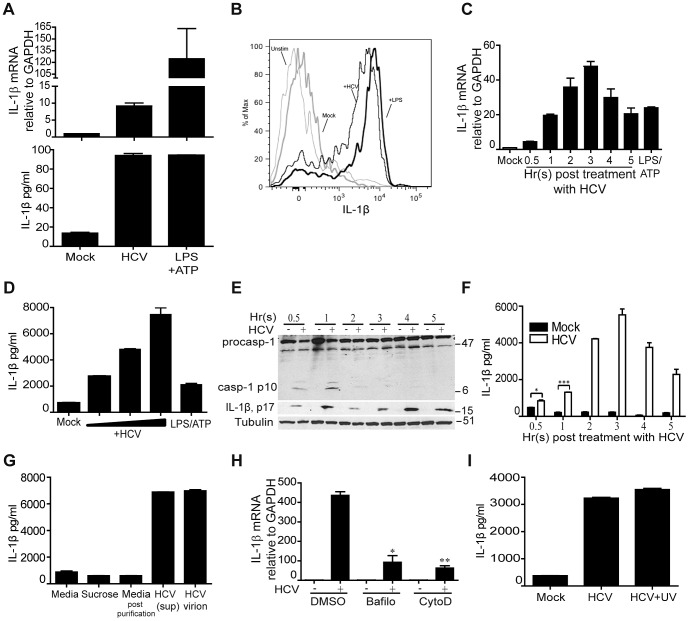
HCV stimulates IL-1β production upon uptake by macrophages.(A) IL-1β mRNA expression (upper panel) and secreted IL-1β protein levels (lower panel) from primary monocyte-derived macrophages of healthy human donor blood. Cells were mock-treated or treated with infectious HCV supernatant (moi = 0.01 based on Huh7 focus forming units (ffu) or treated with 1 µg/ml of LPS and ATP 5 mM (LPS/ATP; positive control). (B) Intracellular cytokine staining of treated CD14+ cells recovered from saline washout of healthy donor liver. Cells were left untreated (unstim) or were cultured with conditioned media (mock, negative control), LPS (positive control) or treated with UV-inactivated HCV (moi = 0.01 based on Huh7 focus forming units (ffu)). Data are shown from one donor and are representative two experiments each of cells collected from two independent donors. In the analysis shown the frequency of IL-1β-expressing cells was: unstim, 2.7%; mock, 6.4%; LPS, 76.5%; UV-HCV. 67.6%. (C)–(I) Analysis of THP1 cells. (C) IL-1β mRNA expression post exposure to HCV. (D) IL-1β protein secretion after treatment with variable doses of HCV (moi = 0.001, 0.01 or 0.1 Huh7 ffu) or LPS/ATP at 1 µg/ml for 24 hr. (E) Immunoblot showing the kinetics of caspase-1 activation after HCV exposure. (F) Levels of secreted IL-1β over a time course after HCV exposure (moi = 0.01 based on Huh7 ffu). (G) IL-1β levels secreted 24 hr after exposure to (left to right) cell culture media, sucrose solution, sucrose-purified culture media, infectious HCV supernatant or sucrose-purified HCV virions. (H) IL-1β mRNA expression in pre-treated with DMSO (control), bafilomycin (2.5 uM) or cytochalasin D (10 µM) cells and exposed to media or infectious HCV supernatant (moi = 0.01 Huh7 ffu). (I) Levels of secreted IL-1β 24 hr post treatment with conditioned media alone (mock) or treatment with live infectious HCV (HCV, moi = 0.01) or UV-inactivated HCV (HCV-UV). *P = 0.0175 and ***P = 0.0005, by student t-test.